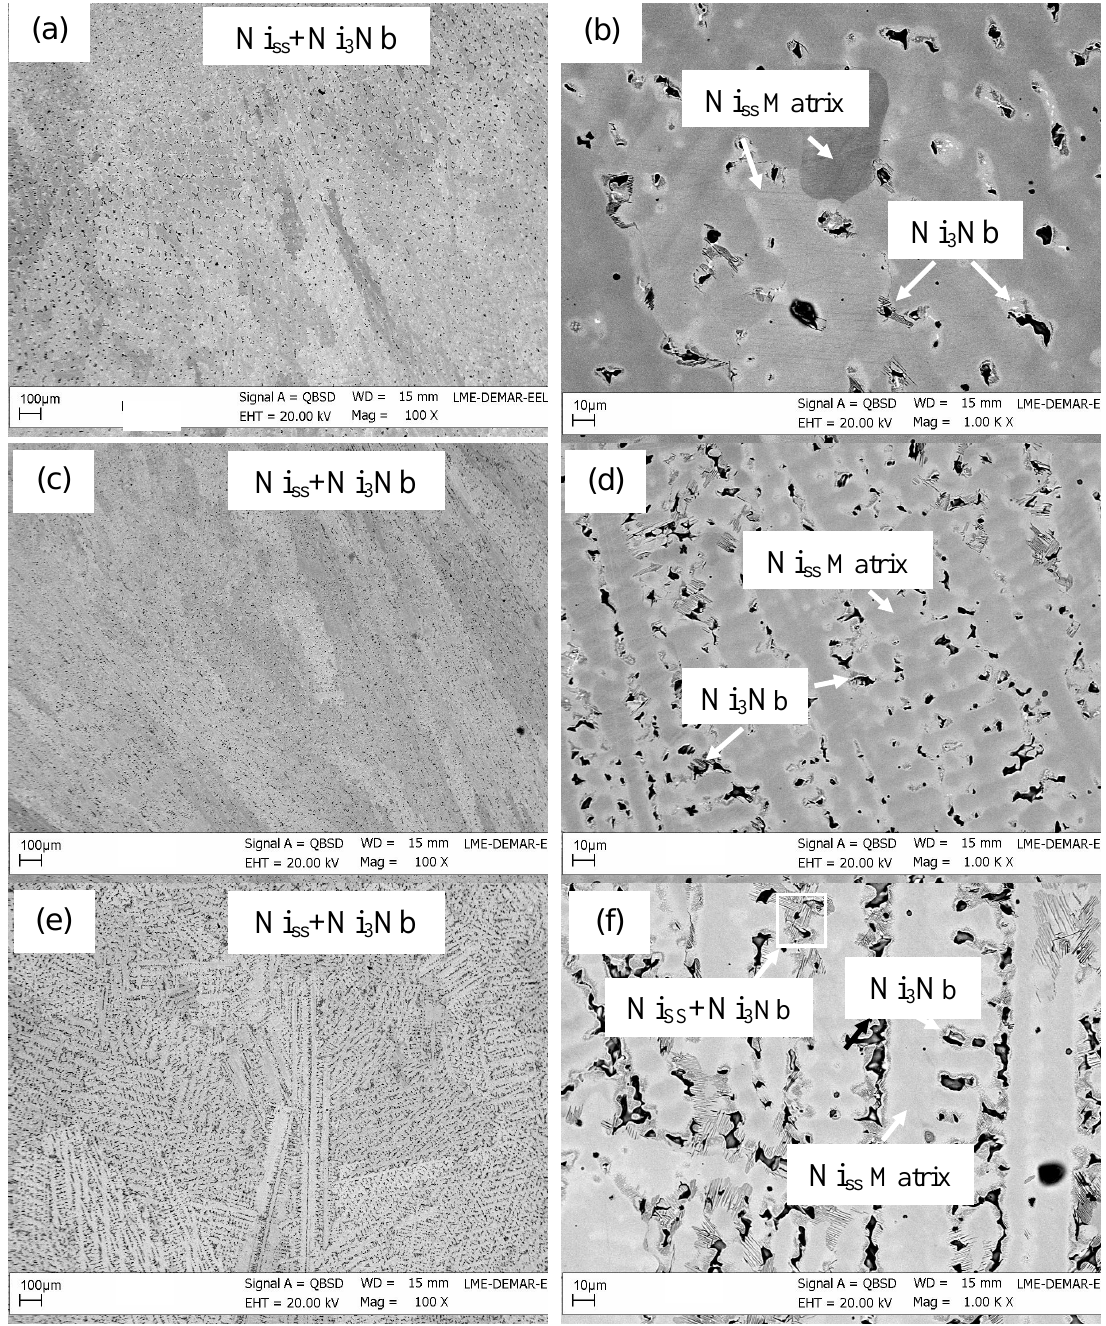
Figure 3 . SEM images of the as-cast ( a,d ) Ni-24Cr-8Nb, ( b,e ) Ni-22Cr-10Nb and ( c,f ) Ni-20Cr-12Nb Figure 3. SEM images of the as-cast ( a , d ) Ni-24Cr-8Nb, ( b , e ) Ni-22Cr-10Nb and ( c , f ) Ni-20Cr-12Nb alloys: ( a and c ) Without chemical attack and ( b,d,f ) after chemical attack. alloys: ( a , c ) Without chemical attack and ( b , d , f ) after chemical